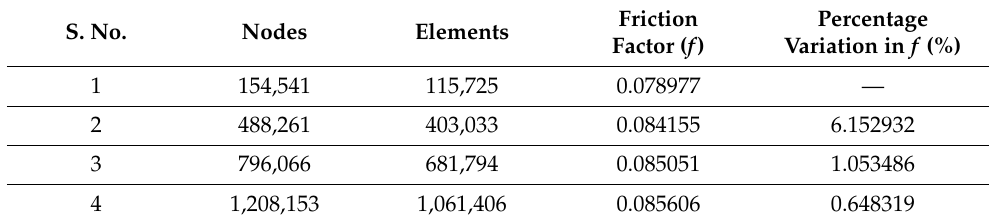
Table 3. Mesh independence